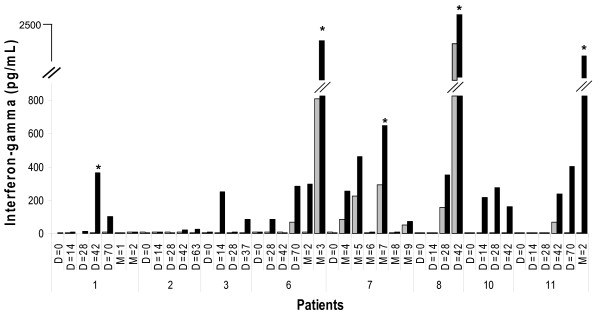
Cellular immune responses in vaccinated patients. Peripheral blood mononuclear cells were collected at the indicated day (D) or month (M) following initial immunization. Peripheral blood mononuclear cells were co-cultured with CMMT 110/C1 cells infected with a multiplicity of infection (MOI) of 40 plaque-forming units (pfu)/cell of fowlpox virus expressing CEA, MUC-1 and TRICOM (Black), or fowlpox virus expressing PSA and TRICOM; (Grey). *Denotes two-fold increase of CEA/MUC-1-specific T cell response compared to PSA control.